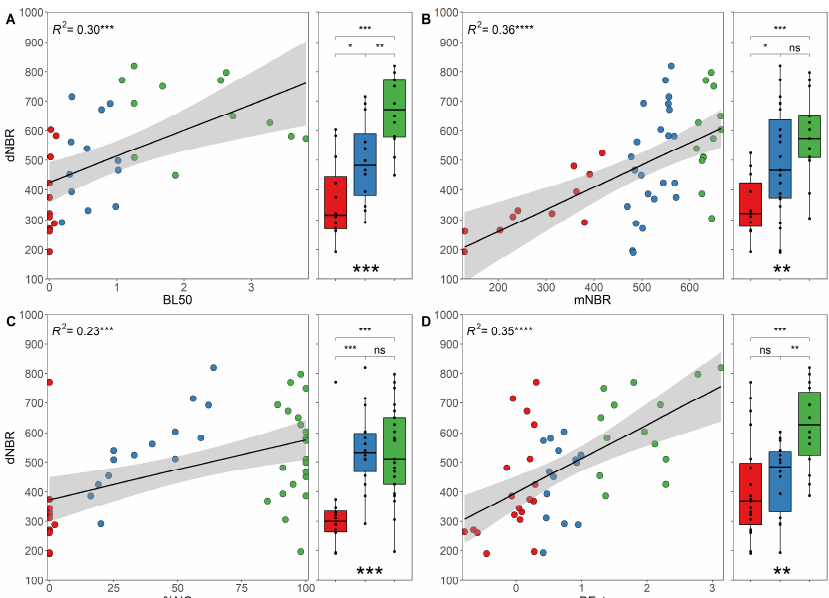
Figure 11. Relationship between variables that improved RF model performance and dNBR . Only variables that have a significant relationship with dNBR shown. From most to least important: ( A ) BL50 ( B ) mNBR , ( C ) %NC, ( D ) BExt. See Table 3 for full variable names and descriptions. Each scatterplot includes a boxplot with fires split into groups based on di ff erences within each variable. MW between group test significance is shown above each boxplot, and KW overall test significance is shown below.